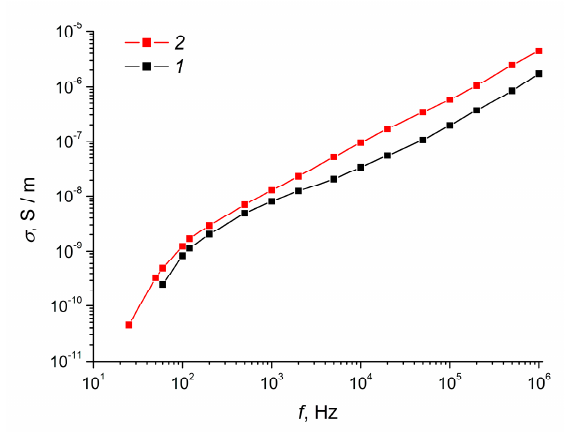
Figure 3. Conductivity of elastomeric composites filled with ( 1 ) MnO 2 -0 or ( 2 ) MnO 2 -E as a function of frequency.